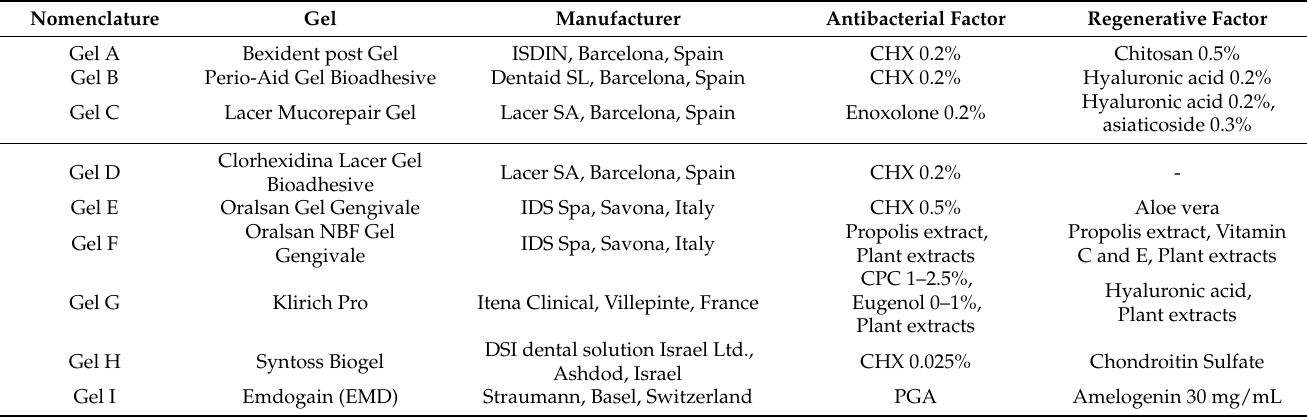
Table 1. Different periodontal gels used in this study with the antibacterial and regenerative components. (CHX: chlorhexi- dine, CPC: cetylpyridinium chloride; PGA: propylene glycol